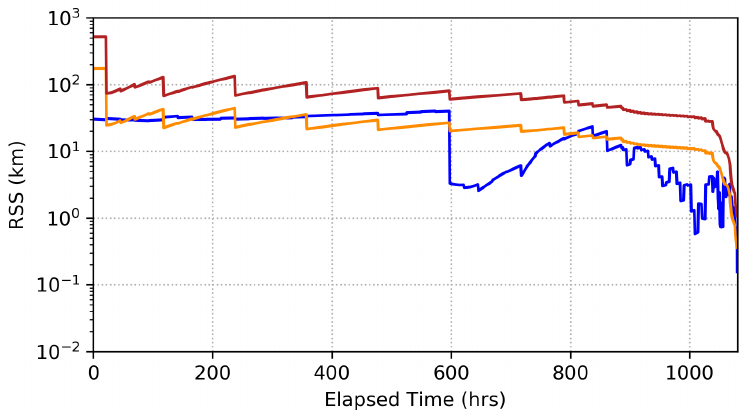
Figure 3. Position error (blue) and square root of the trace of the position covariance (RTPC, 1- σ (orange) and 3- σ (red)) for optical-only filter in the no-biasing setup.